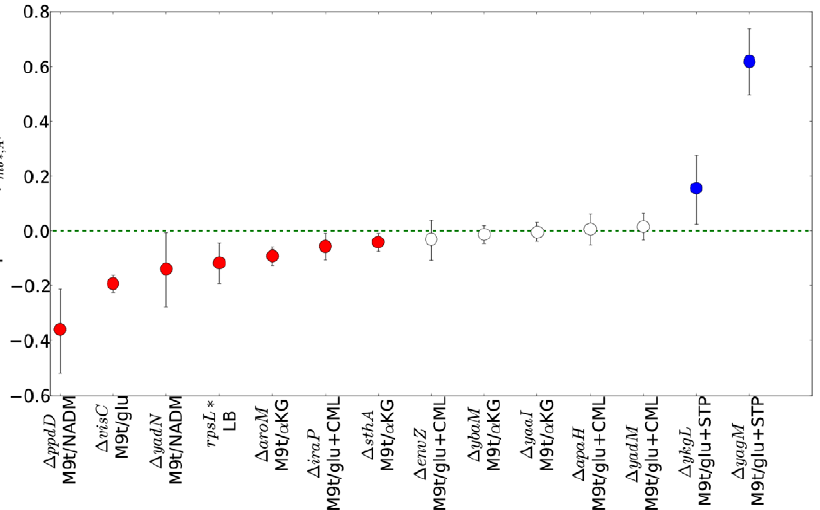
Figure 4. Epistatic interactions between rho * and secondary mutations. For each combination of a secondary mutation A and media condition (shown on the x axis) considered in our follow-up experiments, the multiplicative epistasis e rho*,A (see Eq. S7) is plotted, along with error bars showing a 95% confidence interval (see Text S1, Section 1.3). Significant interactions (those for which the confidence intervals do not overlap with zero) are colored according to their sign. Positive values of e rho*,A indicate positive epistasis between rho * and the secondary mutation in question ( i.e. , the fitness of the double mutant is higher than that expected based on the effects of the two mutations in isolation). Complete data for all strains are given in Table S4. rpsL * strains in LB + ethanol are not shown due to the complete absence of wild type growth in this